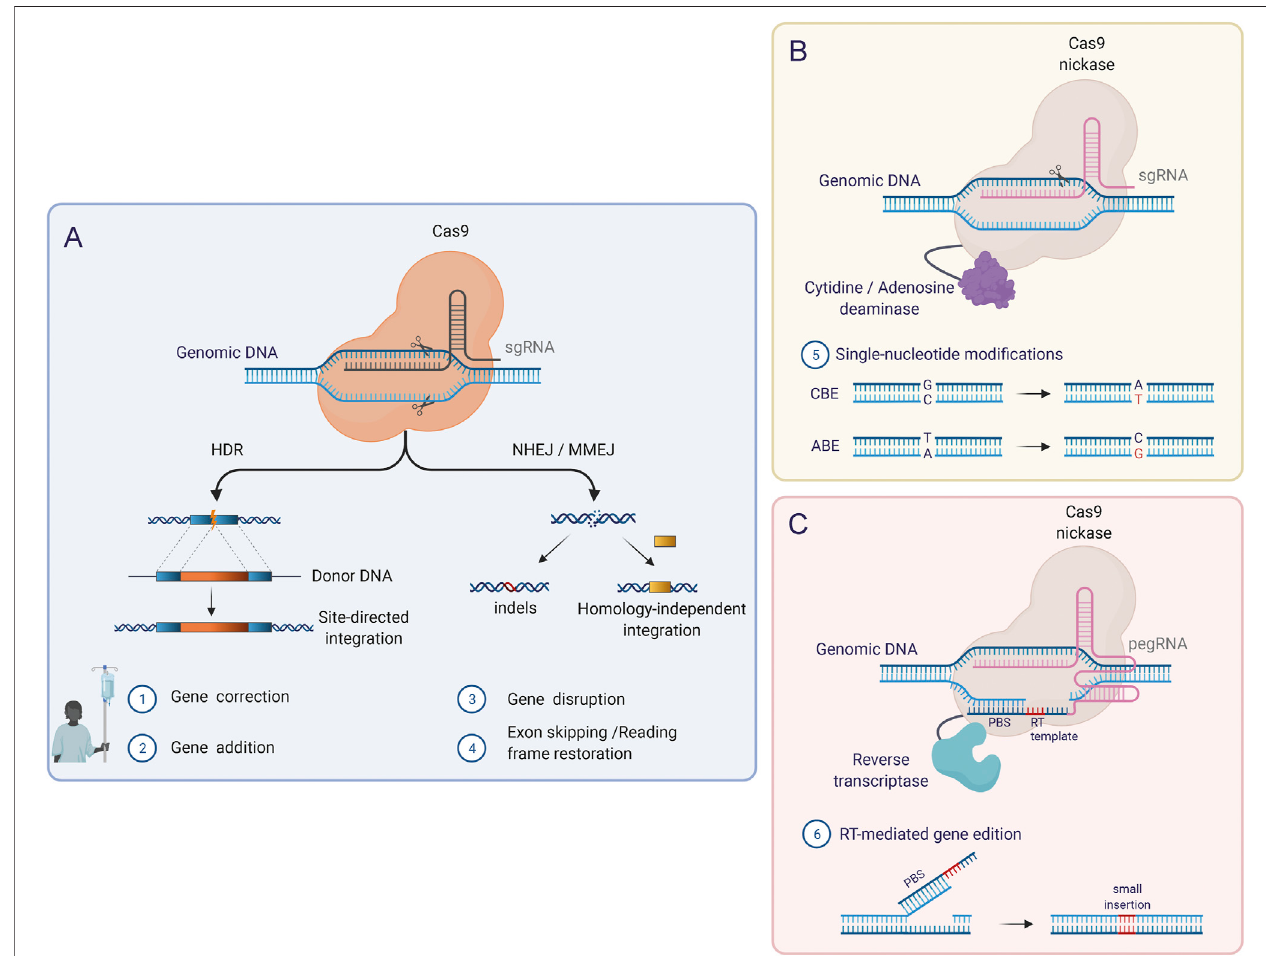
FIGURE 4 | Genome editing tools based on CRISPR/Cas. (A) The original CRISPR/Cas RNA-guided nuclease system induces DSBs in the genome in a targeted manner and requires binding of the single guide RNA molecule (sgRNA) to the target DNA as well as the recognition of a speci fi c PAM sequence adjacent to the target sequence.Usingthissystem,thetwomajorDNArepairpathways(HDRandNHEJ)canbeexploitedtointroducemodi fi cationsatthetargetlocus. (B) BaseEditors(BEs) combine Cas nickases lacking one nuclease domain with DNA deaminases. BEs mediate single-nucleotide conversion, which enables the correction of point mutations.TwotypesofBEscanbedistinguished:Cytosinebaseeditors(CBEs),whichmediateC-GtoT-Aconversions,andadeninebaseeditors(ABEs)whichinduce A-T to G-C conversions. (C) Prime Editors (PEs) can induce point mutations, small insertions, and small deletions and consist of a Cas nickase fused to a reverse transcriptase(RT)domain. Inthissystem,areformulatedprimeeditinggRNA(pegRNA)confersthespeci fi city(likethesgRNAs)butadditionallycontainsthetemplatefor the desired DNA modi fi cations in the 3 ′ end. After the induction of a single-strand break (SSB) by the Cas9 nickase, the 3 ′ end of the pegRNA (primer binding site; PBS) hybridizes with the free 3 ′ DNA end and acts as a reverse transcription template.